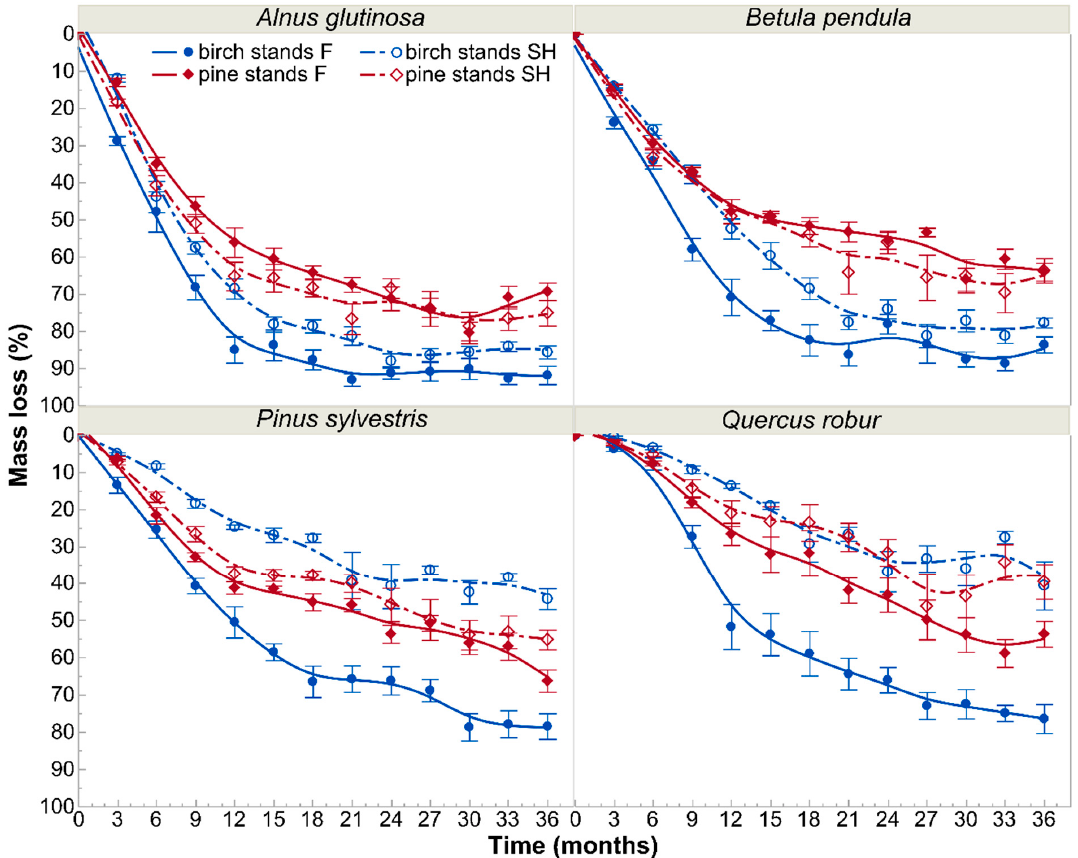
Figure 1. Decomposition rates of particular tree species leaf litter in birch and pine stands growing on two different site types—post-mining external spoil heap (SH) or forest sites (F). Decay lines were smoothed by cubic splines with lambda of 0.1. The markers on the graph show mean values ( ± SE) of mass loss of particular tree species at particular collection